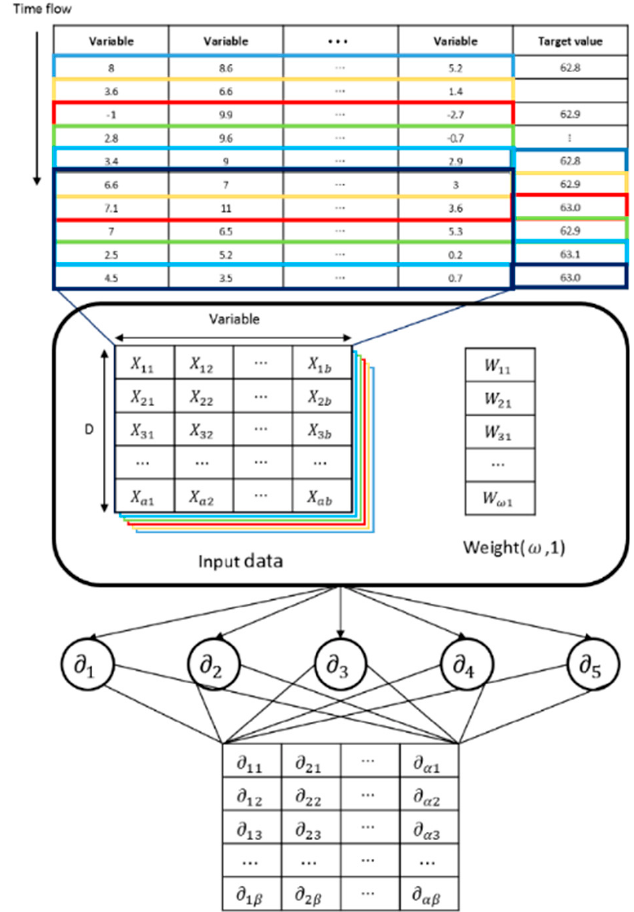
Figure 21. Data reordering process and the calculation process for the CNN algorithm.